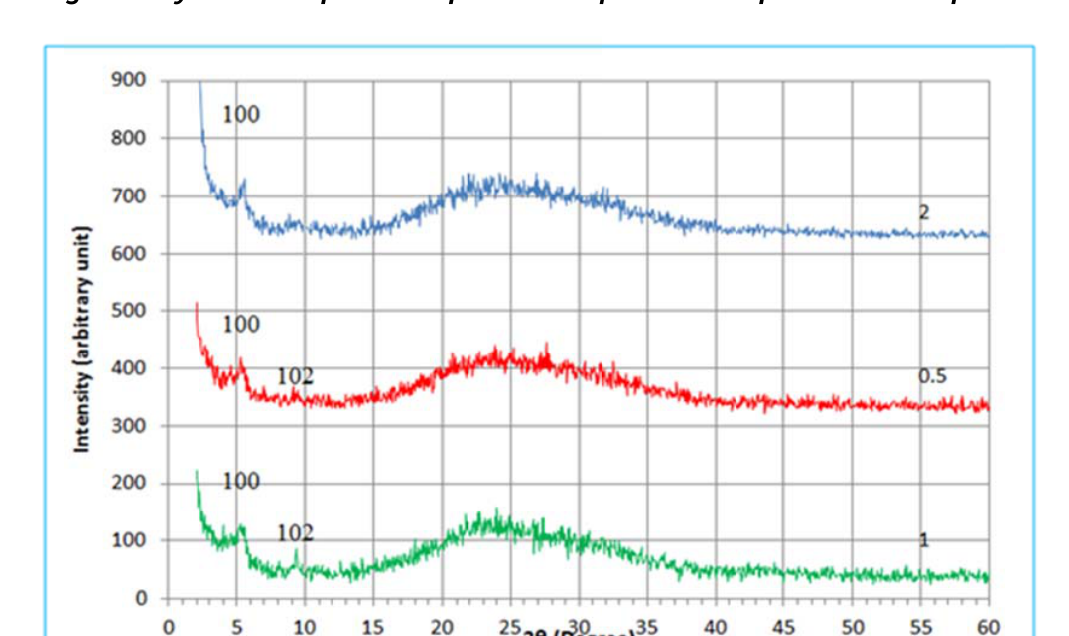
.5: X-ray diff subs strates with d FT -